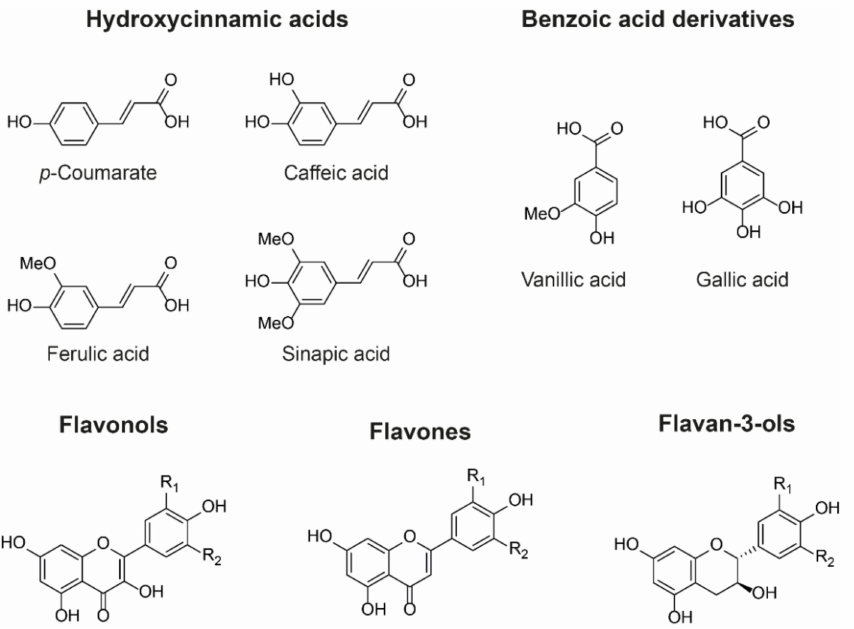
Figure 6. Examples of chemical structures of commonly observed co-pigments. In nature, co- pigmentation is dependent on co-localisation of anthocyanins and co-pigments within the vacuole. Consequently, flavone and flavonol co-pigments are glycosylated in order to facilitate their transport to the vacuole. Hydroxycinnamoyl quinic acids such as 3- O -caffeoyl and 3- O - p -coumaroyl quinic acids can be transported to the vacuole as aglycones and are found as co-pigments in hydrangea flowers, for example